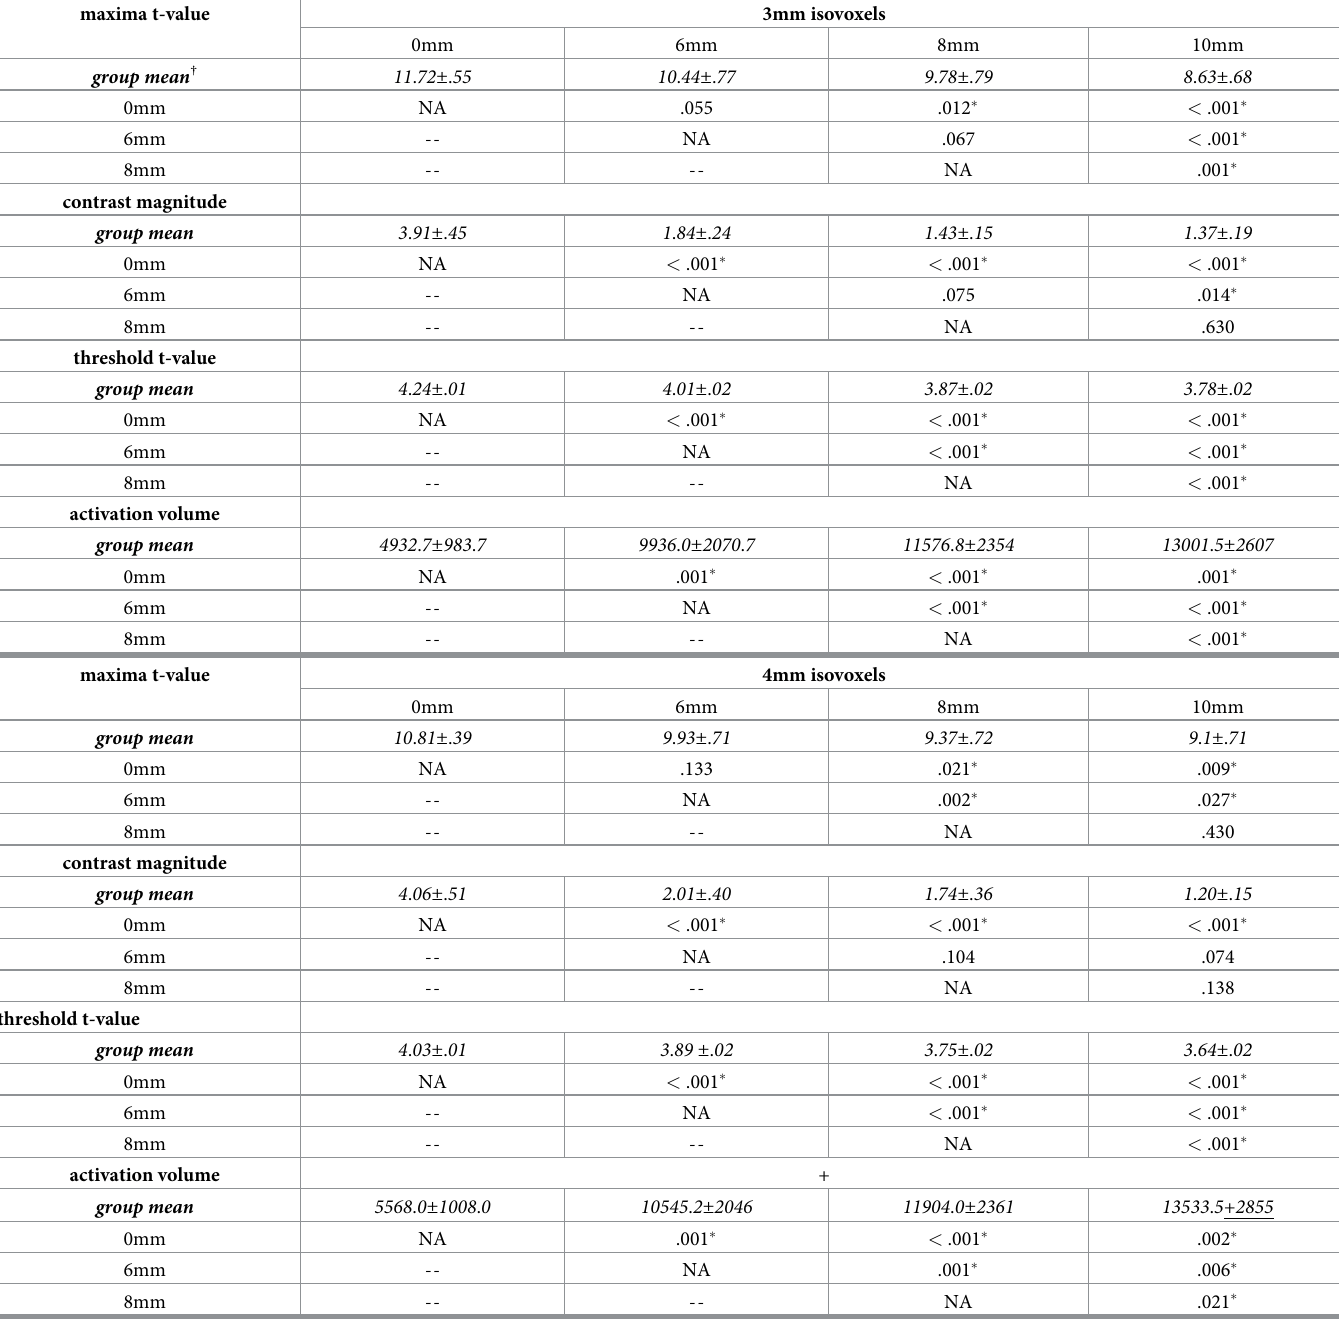
Table 4. Smoothing kernel effects on SMC activation during sequence learning. maxima